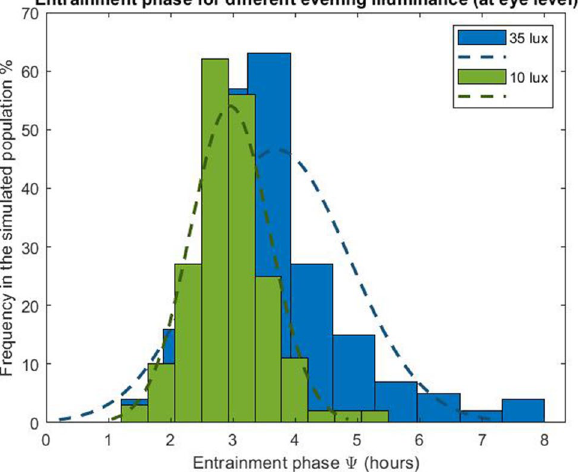
Figure 5. Entrainment phase angle distribution for a population of 200 simulated individuals with a normally distributed intrinsic circadian period with means (± SD) of 24.15 (± 0.2) h 33 . Illuminances refer to corneal light exposure (i.e., at the eye). Results are presented for daytime (wake-19:00) illuminances (L 1 ) of 200, 800 and 2000 lx, and evening (19:00-sleep onset) illuminance (L 2 ) set to the values indicated on the x-axis. The central marker indicates the median, and the bottom and top edges indicate the 25th and 75th percentiles, respectively. The whiskers extend to the most extreme data points (population minima and maxima). We note that in the absence of sufficient differentiation between daytime and evening light the model fails to entrain as also noted and discussed in 26 . Results are presented only for combinations of daytime-evening illuminances and intrinsic circadian periods for which the model entrains to 24-h